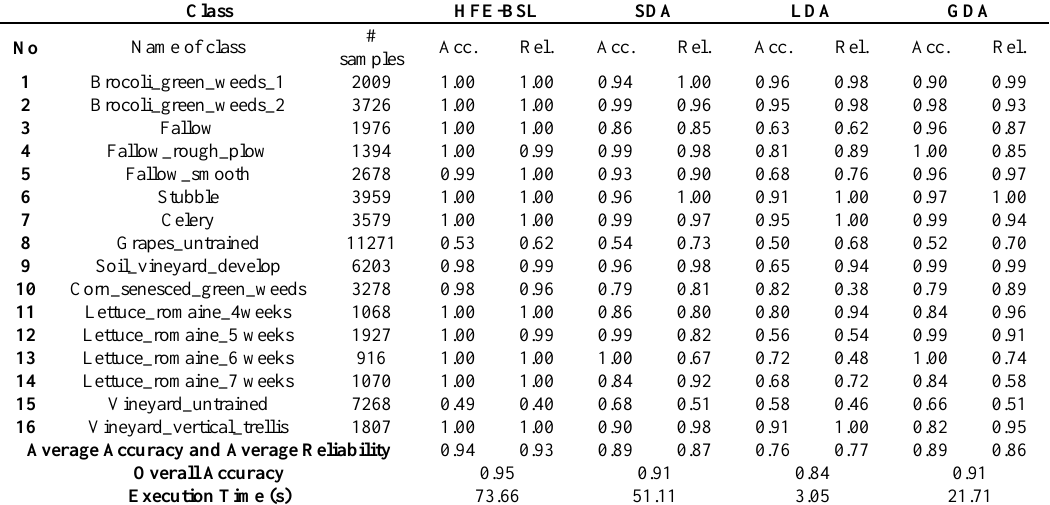
Table 3. Accuracies and reliabilities obtained for each class of Salinas using 10 extracted features and 16 training samples. Class HFE-BSL SDA LDA